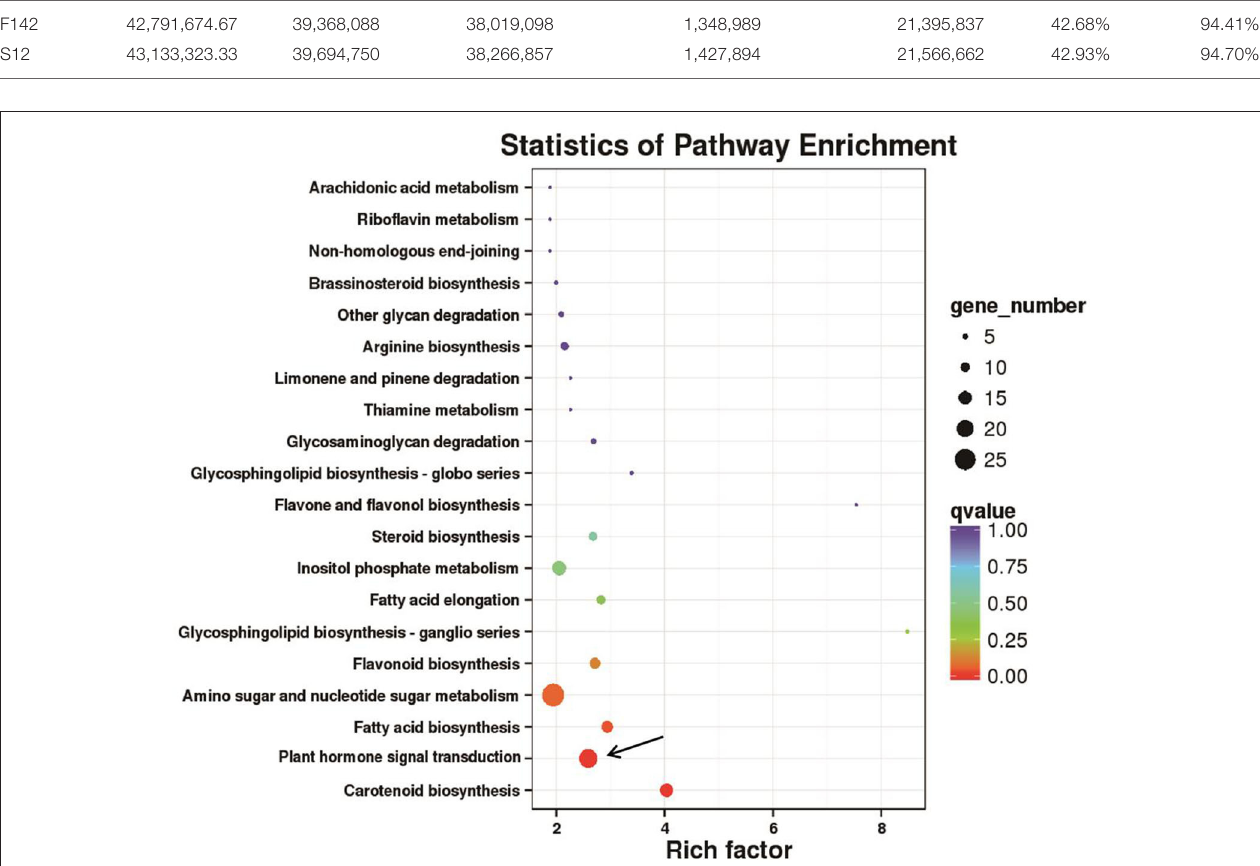
FIGURE 2 | Kyoto Encyclopedia of Genes and Genomes (KEGG) pathway enrichment analysis of 2,670 differentially expressed genes (DEGs). The pathway of plant hormone signal transduction was mainly enriched (black arrows).